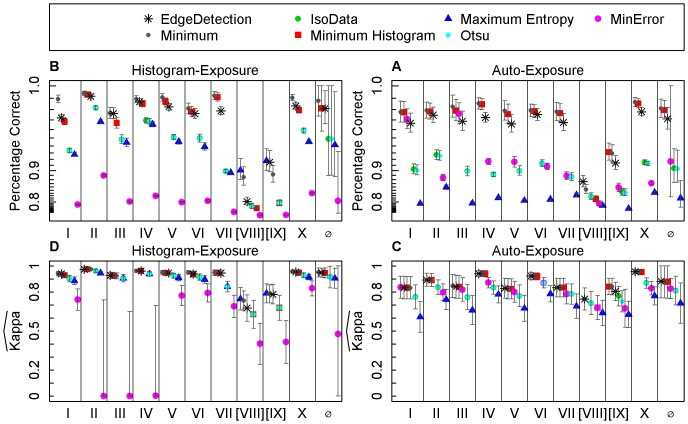
Accuracy assessment of seven binarization algorithms for hemispherical photographs. Percentage correct and kappa values of binarizations obtained from different algorithms applied to hemispherical photographs. Photographs were taken at ten locations (indicated by latin numbers) and either histogram- or auto-exposed. Whiskers represent confidence intervals with a confidence level of 95%.